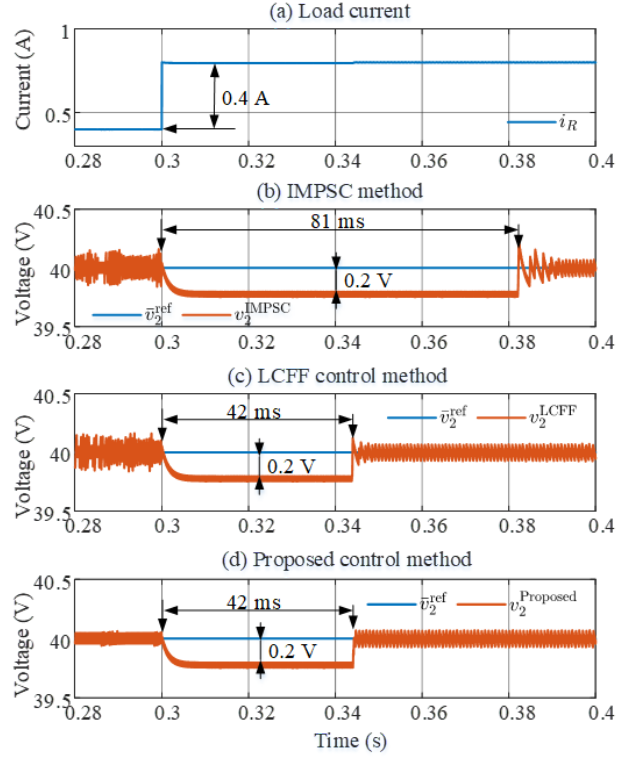
Figure 8. Simulation results of the output voltage when load steps down from 100 Ω to 50 Ω .